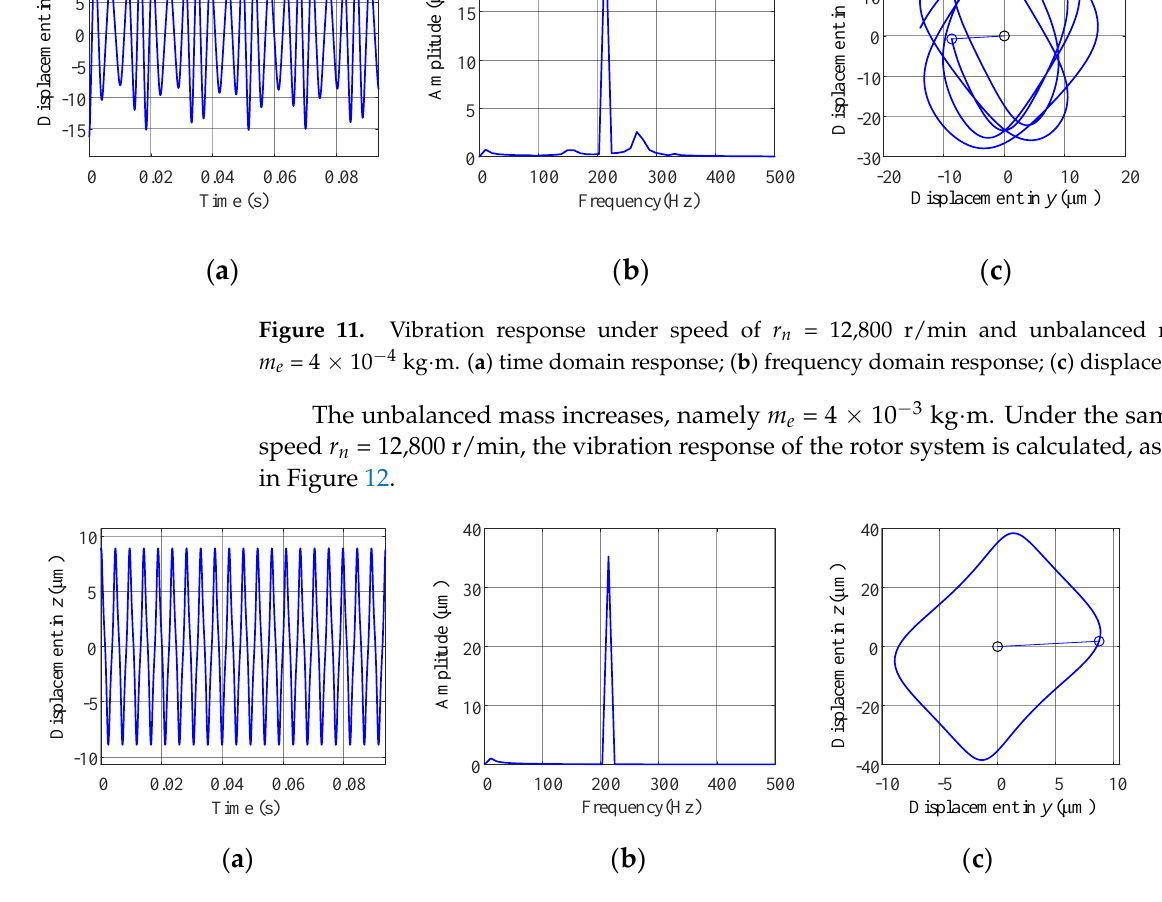
Figure 12. Vibration response under speed of r n = 12,800 r/min and unbalanced mass of m e = 4 × 10 − 3 kg · m. ( a ) time domain response; ( b ) frequency domain response; ( c ) displacement.